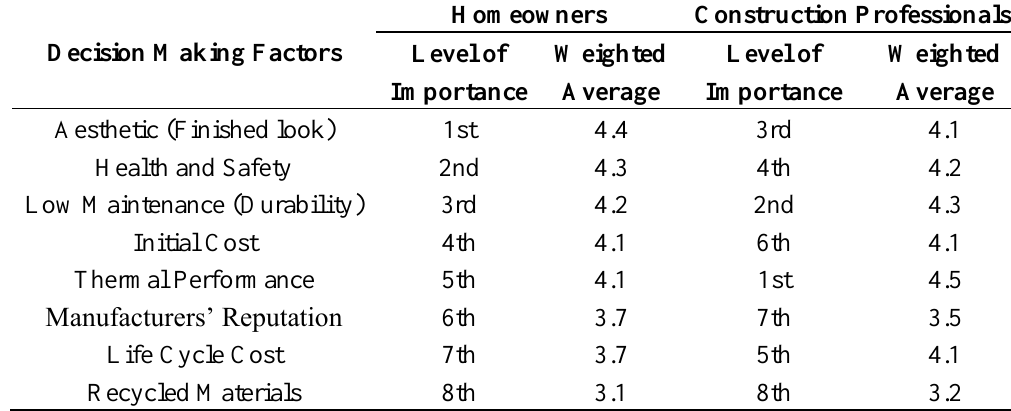
Table 6. Importance about decision making factor for refurbishment materials (Cronbach’s Alpha =